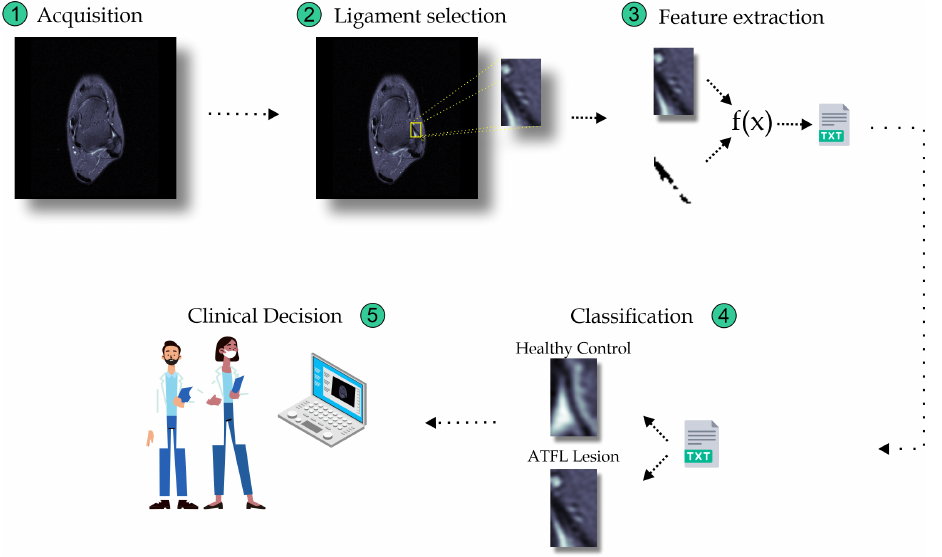
Figure 1. Sequence of stages involved in the clinical decision making of ankle ligament injury from the MRI